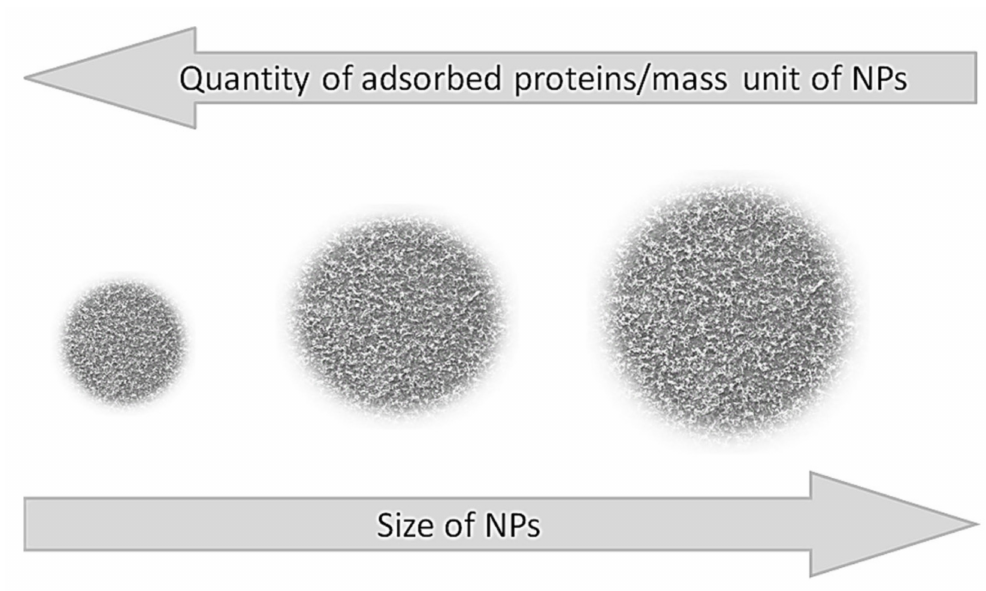
Figure 3. Influence of NP size on the quantity of the adsorbed proteins per mass unit of NP. For NPs larger than 30 nm there is a direct correlation between their specific surface area and the amount of adsorbed proteins. It was shown that at a constant particle weight, the amount of adsorbed plasma proteins increases with the surface area when the same type of NPs—varying in size between 70 and 700 nm—were used [37]. On the other hand, the thickness of the PC is greater in larger NPs, although the total amount of adsorbed proteins is smaller when compared to the same type of NPs but with a smaller diameter [22] and even small variations in the size of the NP (e.g., 10 nm) can drastically a ff ect the composition of the PC